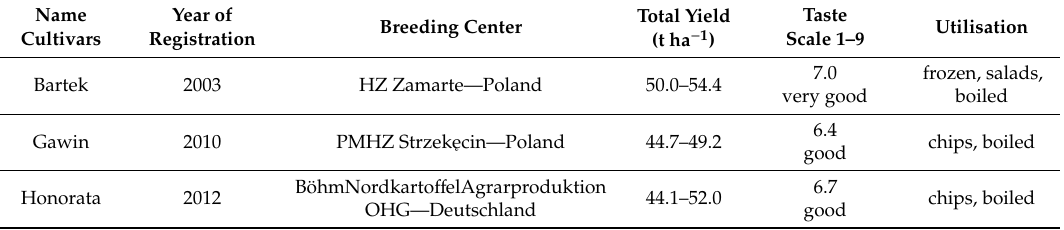
Table 1. Potato cultivars and their most important features